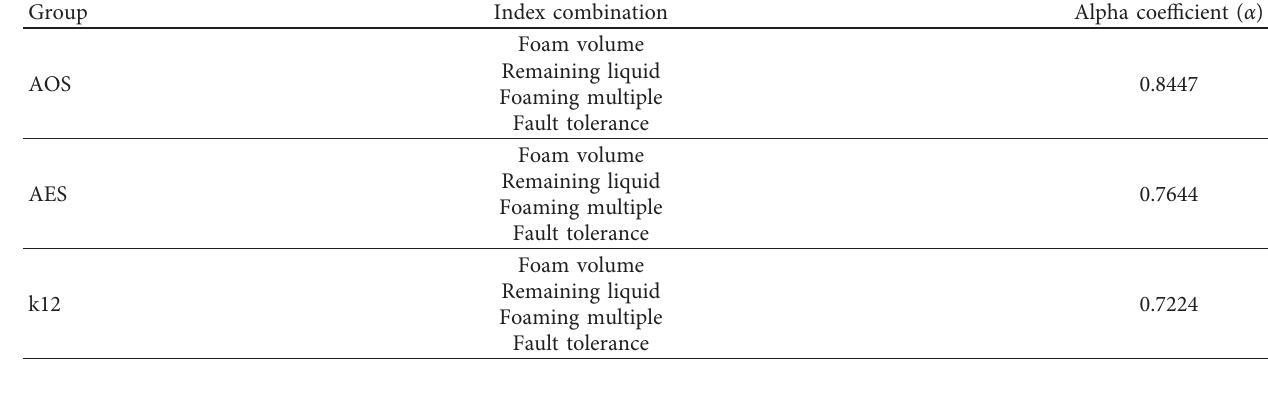
Table 1: Summary table of reliability test results.